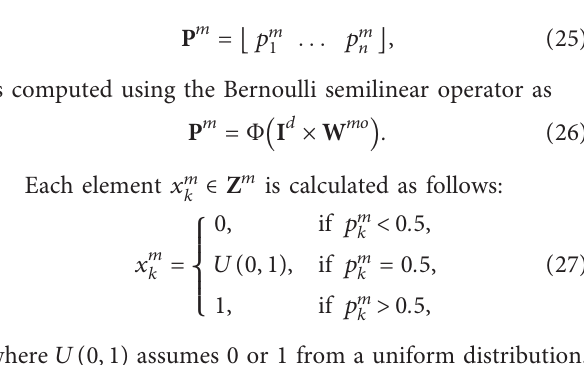
Figure 7: NSFNET topology